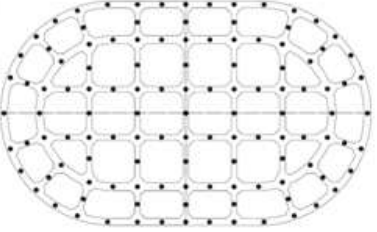
Figure 5. Layout of soil pressure sensors.